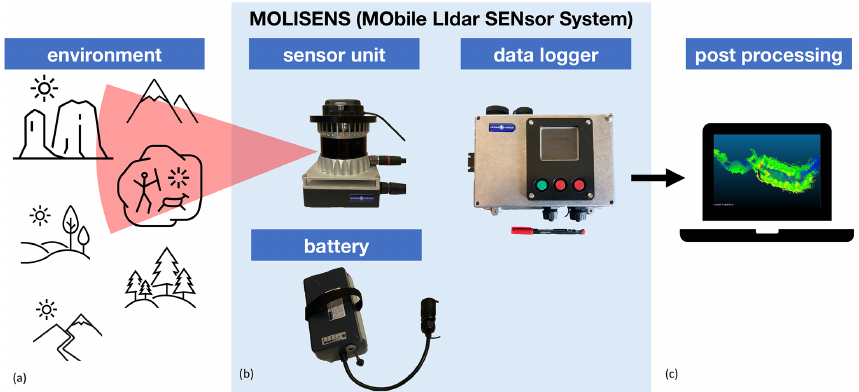
Figure 1. MOLISENS concept with hardware components and interfaces (b) with a pen for scale. The data logger is 21.5cm × 16cm × 14cm and weighs 2.1kg. The sensor unit weighs 1.0kg and the total weight of the complete system is 5.5kg.